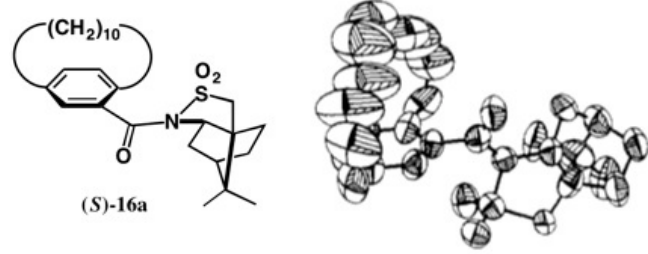
Figure 13. X-ray ORTEP drawing of amide ( S )- 16a . Reprinted with permission from [30].